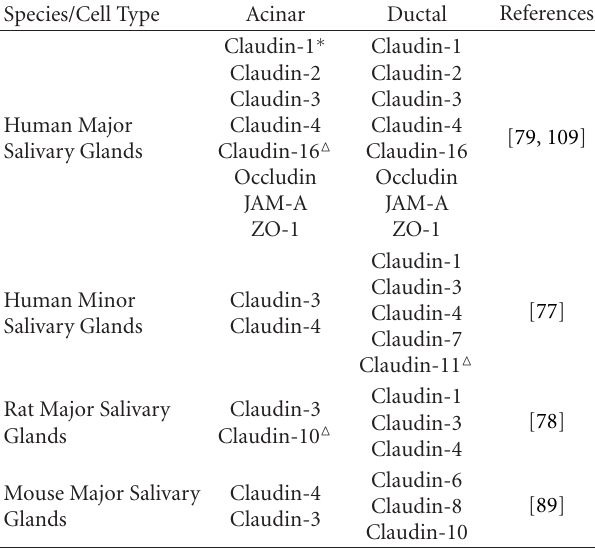
Table 1: Localization of TJ proteins in salivary glands . This table summarizes TJ detected to date in acinar and ductal cells. ∗ indicates that this protein is present only in serous acini. (cid:2) denotes an unusual basolateral or cytoplasmic localization where TJs do not